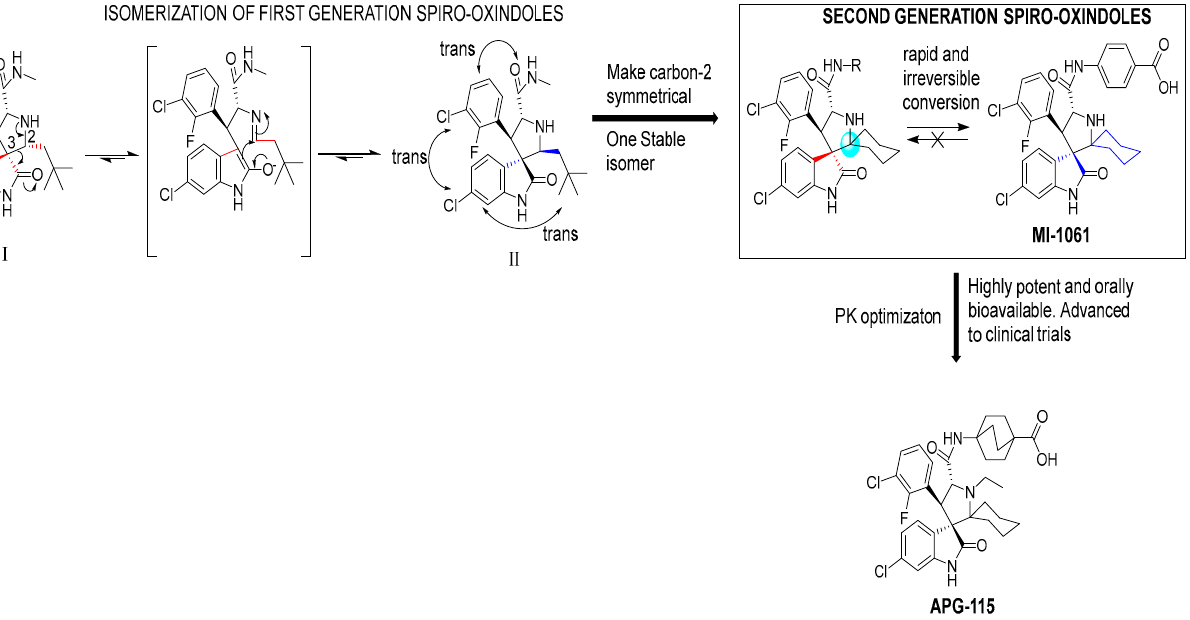
Figure 5. Discovery of second-generation spiro-oxindole class of MDM2 inhibitors. Red lines indicate the starting stereochemistry and the blue lines indicate the desired ending stereochemistry. The blue circle indicates the symmetrical stereocenter in the second-generation spiro-oxindoles.